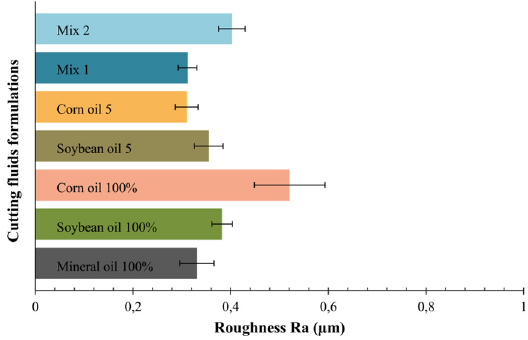
Figure 2. Roughness values of the specimens grinded in different conditions of cooling.